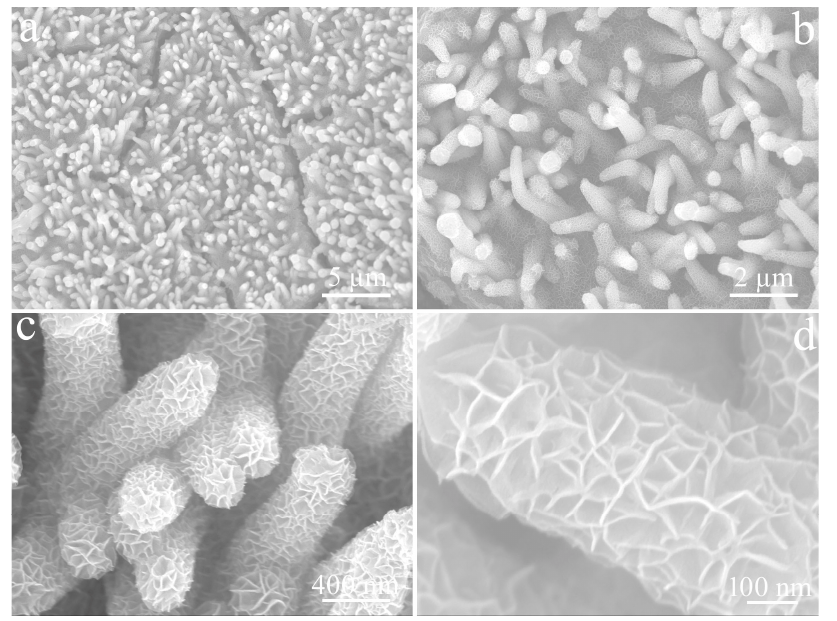
Figure 5. Low ( a – b ) and high ( c – d ) magni fifi cation SEM images of CuO/NCS composite (with NCS layer deposited for 300 s).